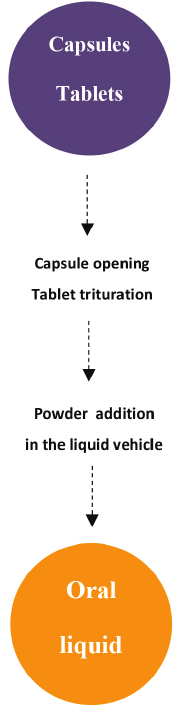
FIGURE 3 - Preparation of the oral liquid formulation from tablet or